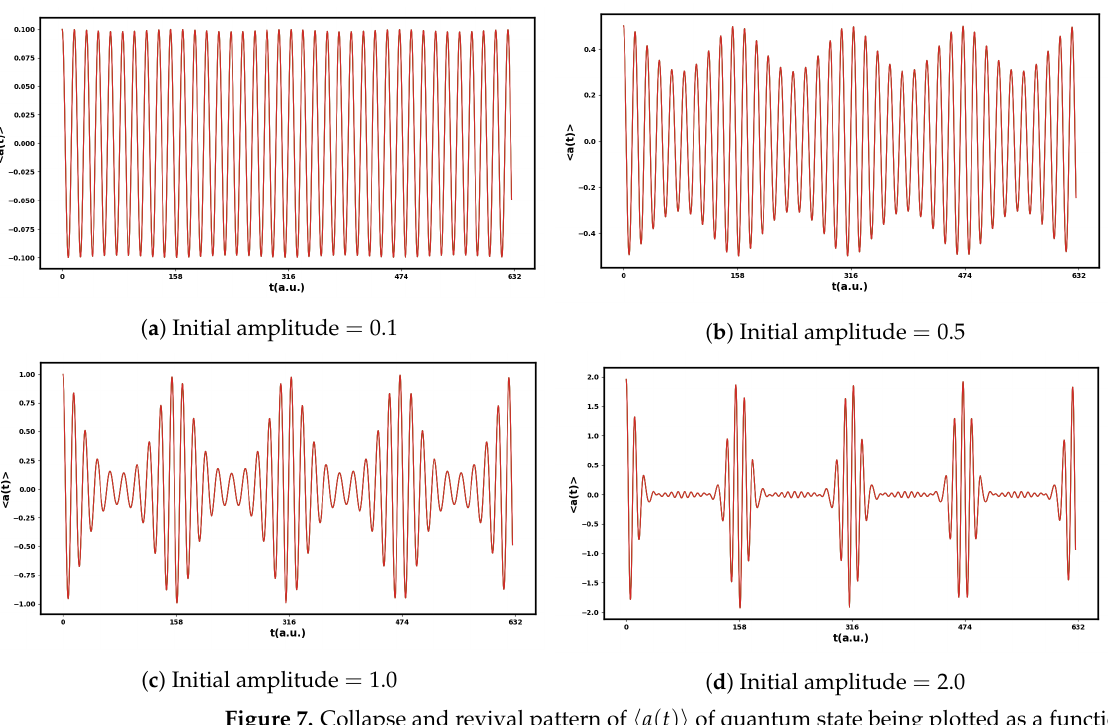
Figure 7. Collapse and revival pattern of (cid:104) a ( t ) (cid:105) of quantum state being plotted as a function of time with nonlinearities ( k c and k m ) and dissipation ( γ c and γ m ) of optical and mechanical modes equal to 0.01 a.u. and 0.00001 a.u., respectively. The pattern is shown for states with initial amplitude = 0.1,0.5,1.0 and